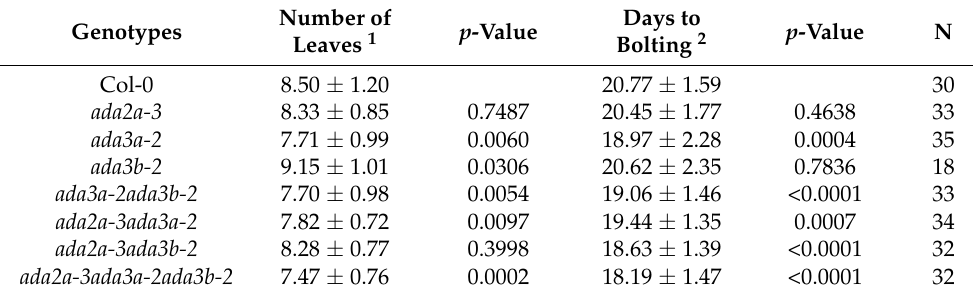
Table 3. The effect of ADA2a on the flowering phenotype of ada3 mutants. Leaf number and days to bolting in single, double, and triple mutant